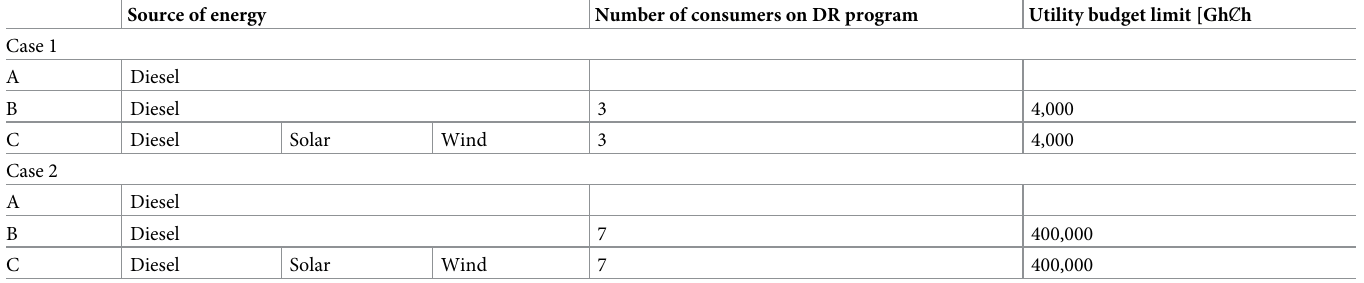
Table 2. Maximum specifications of cases considered in this